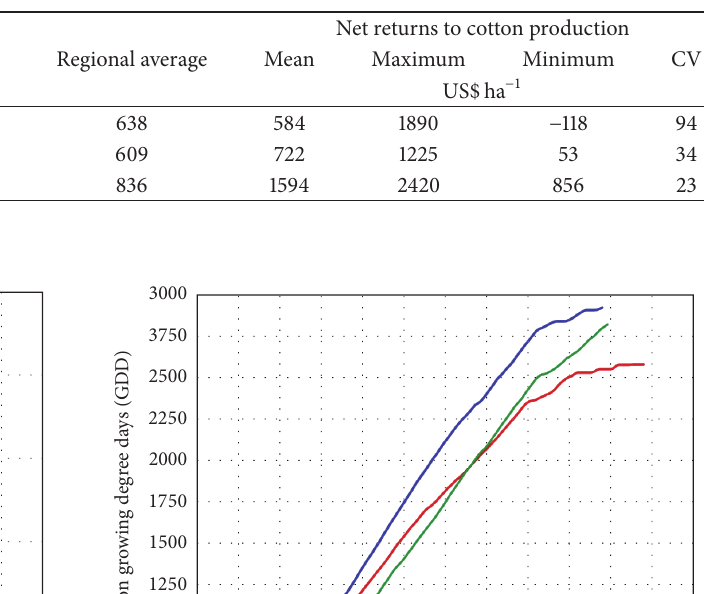
Table 4: Summary statistics for cotton lint yield (kgha −1 ) and net returns (US$ ha −1 ).